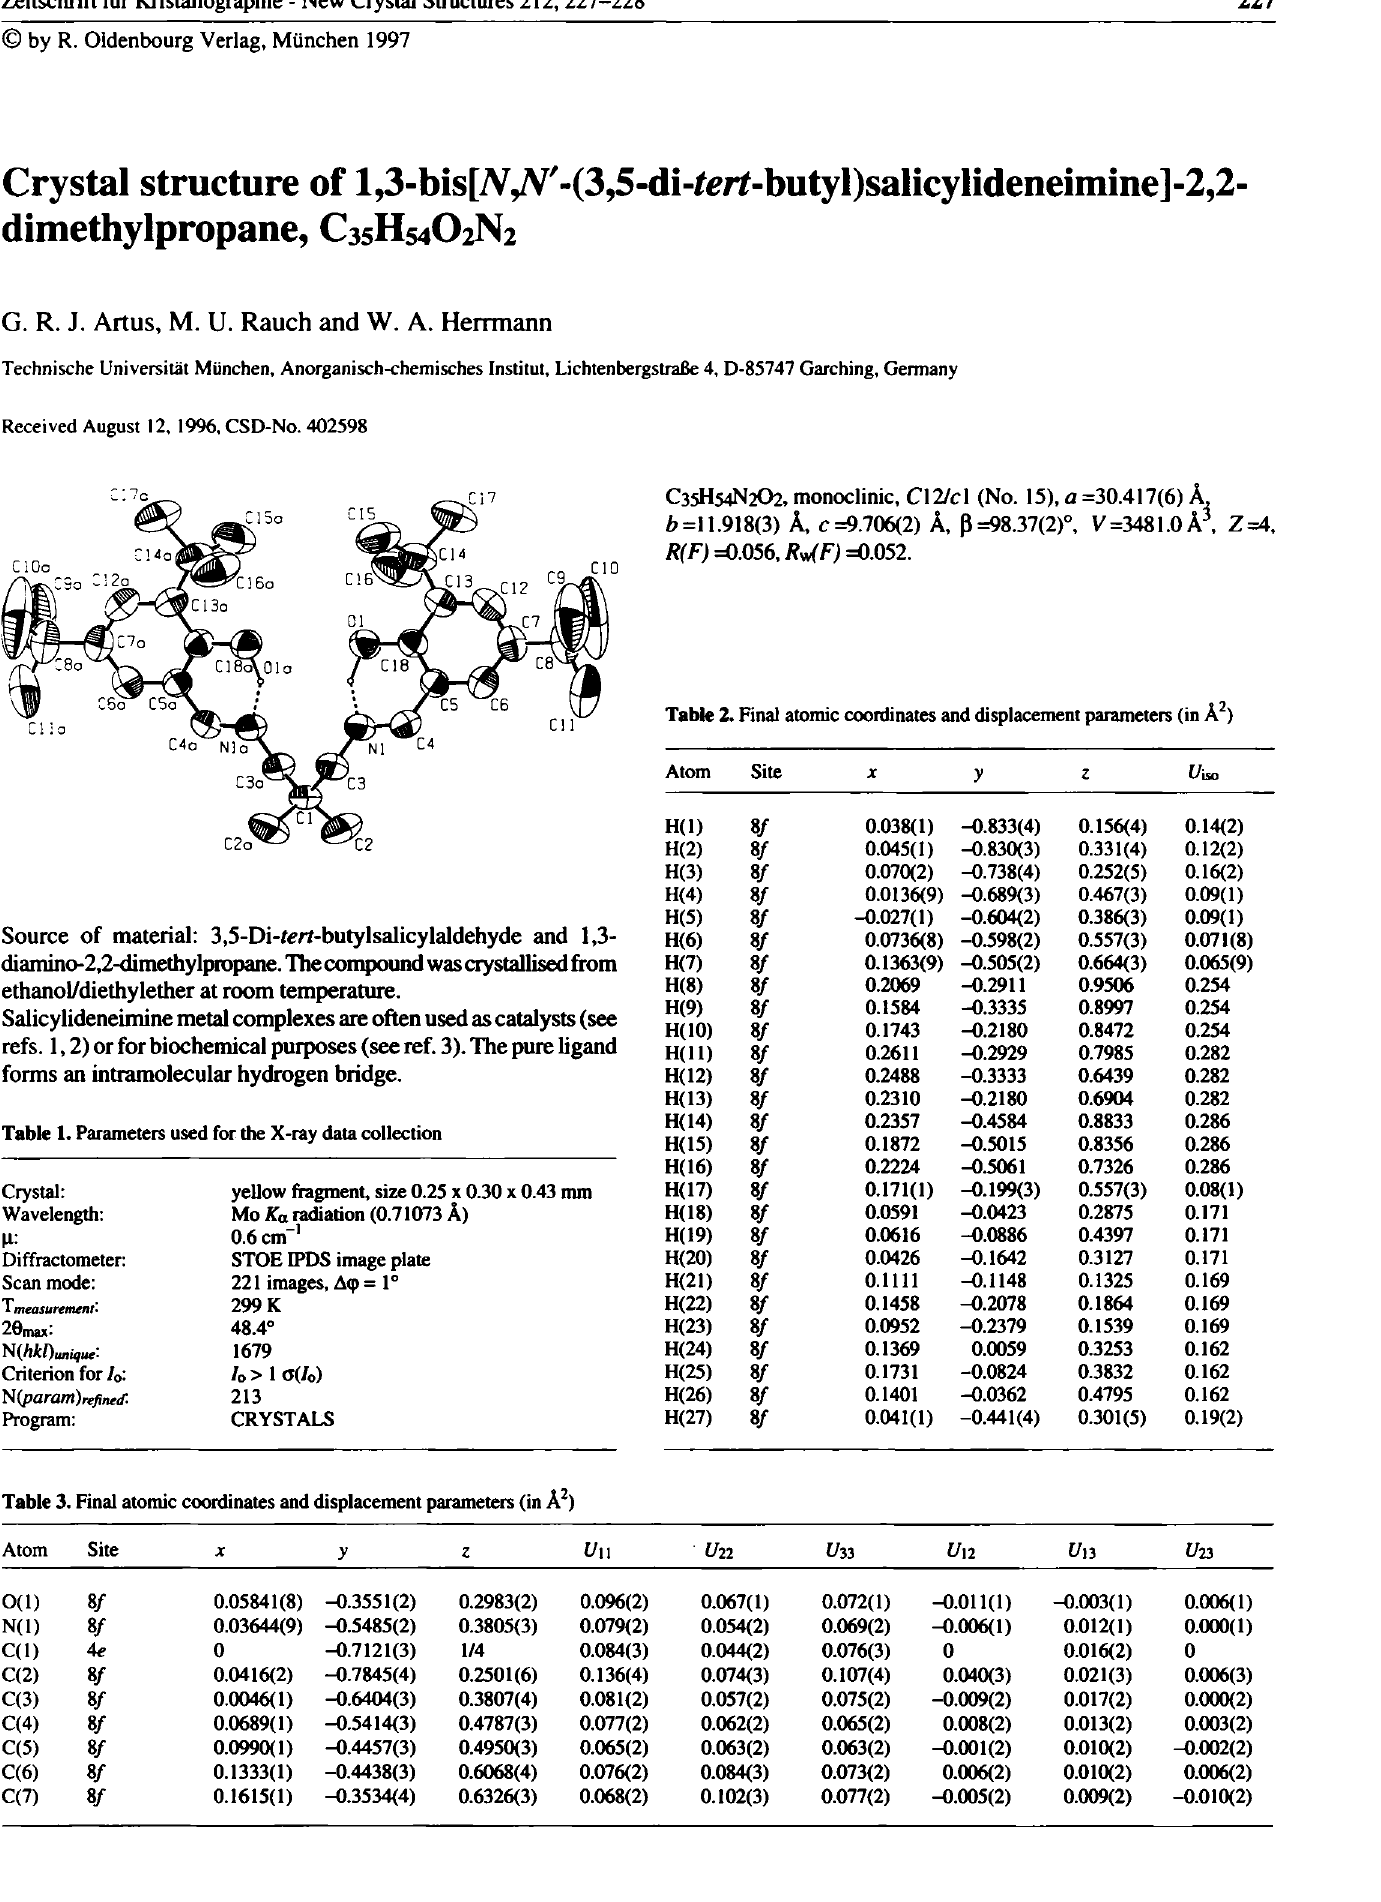
Table 3. Final atomic coordinates and displacement parameters (in Â 2 )